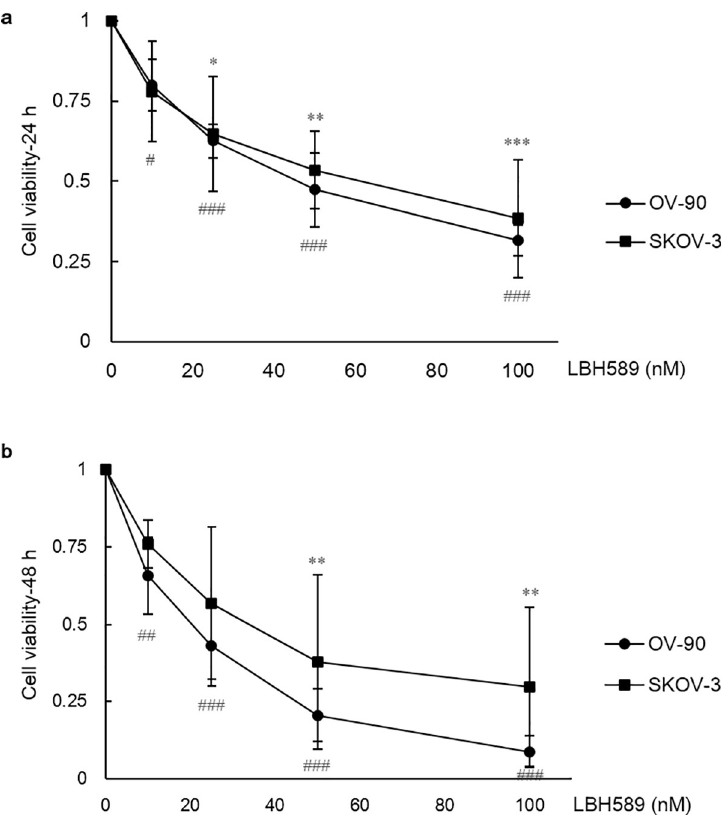
Fig 1. Cellular viability after LBH589 treatment for 24 h and 48 h. LBH589 suppresses cellular viability of OV-90 and SKOV-3 ovarian cancer cell lines. The cell viability was assessed by MTT assay after treatment of LBH589 for 24 h (A) and 48 h (B). Data are shown as mean ± SD of at least three individual experiments ( � P < 0.05, �� P < 0.01, ��� P < 0.001 vs. SKOV-3 control (0.1% DMSO); # P < 0.05, ## P < 0.01, ### P < 0.001 vs. OV-90 control (0.1% DMSO)).